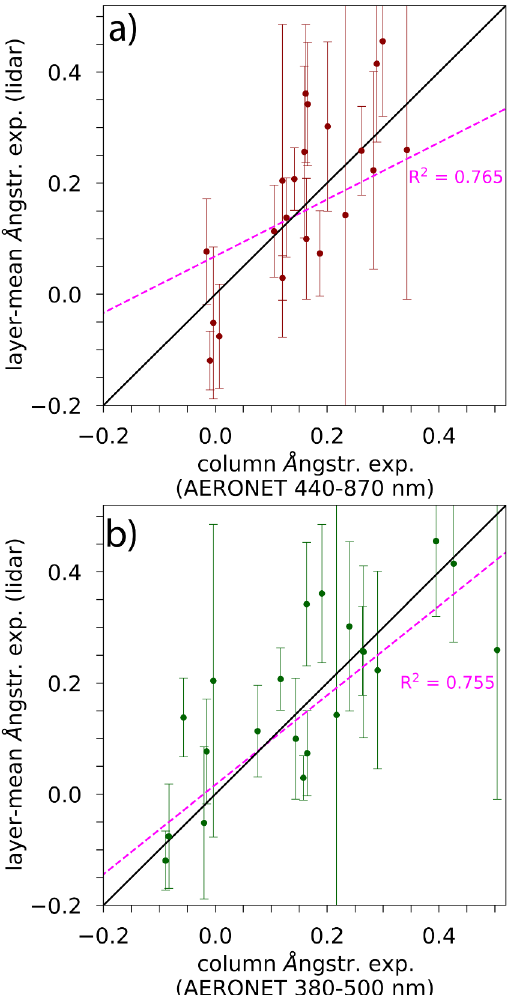
Figure 1: Comparison of layer-mean dust Ångström exponents from lidar with column Ångström exponents from AERONET from the 440-870 nm (a) and 380-500 nm (b) wavelength range. Errorbars indicate the standard deviation within the averaging height